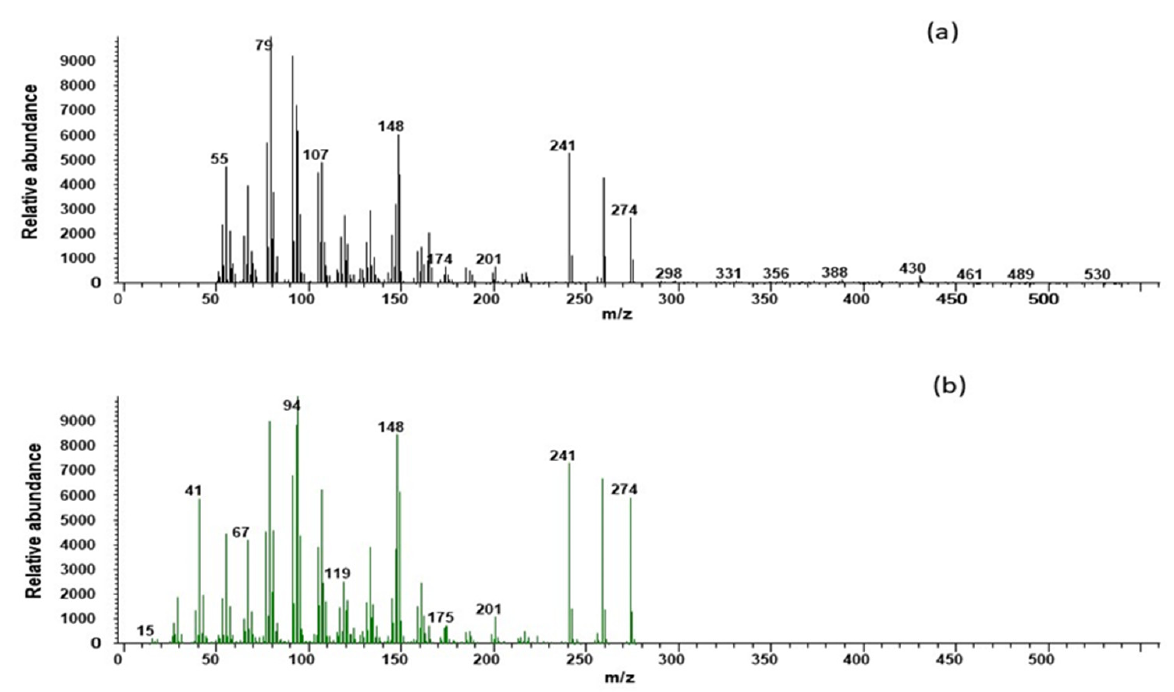
Figure 2. Mass spectra of Androstenol of mouse deer feces ( a ) compared with synthetic androstenol ( b ).